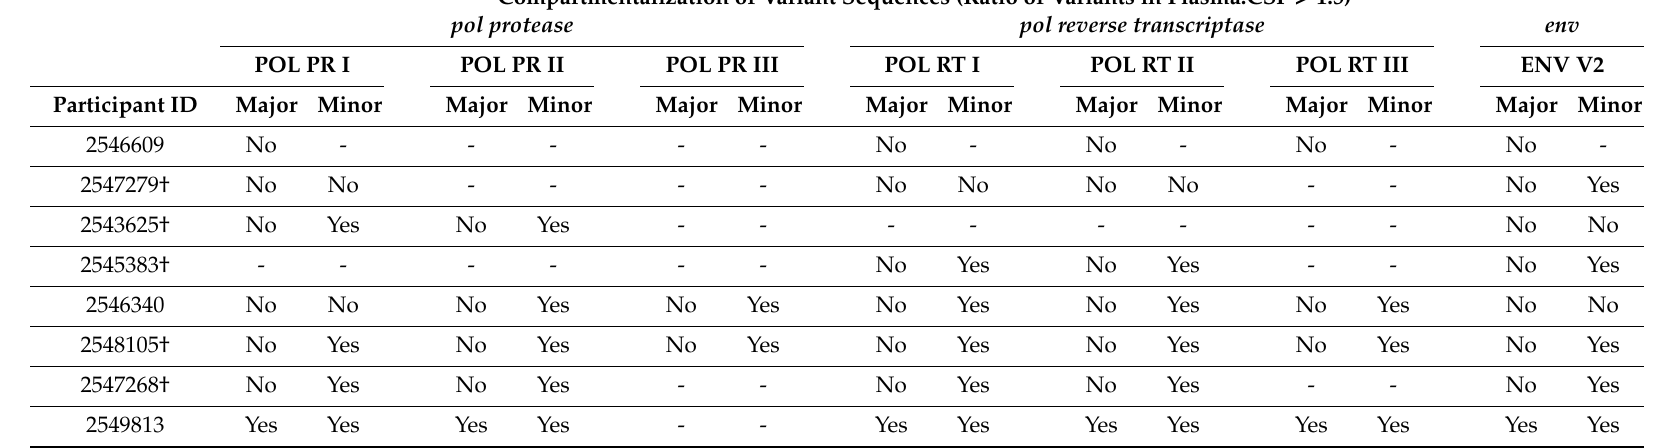
Table 2. Compartmentalization of variant sequences in plasma and